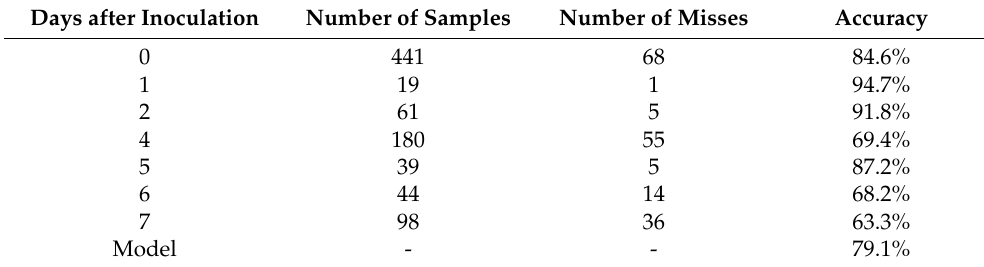
Table 9. Results of a dataset with days 0, 1, 2 after inoculation (Exp3a). Days after Inoculation